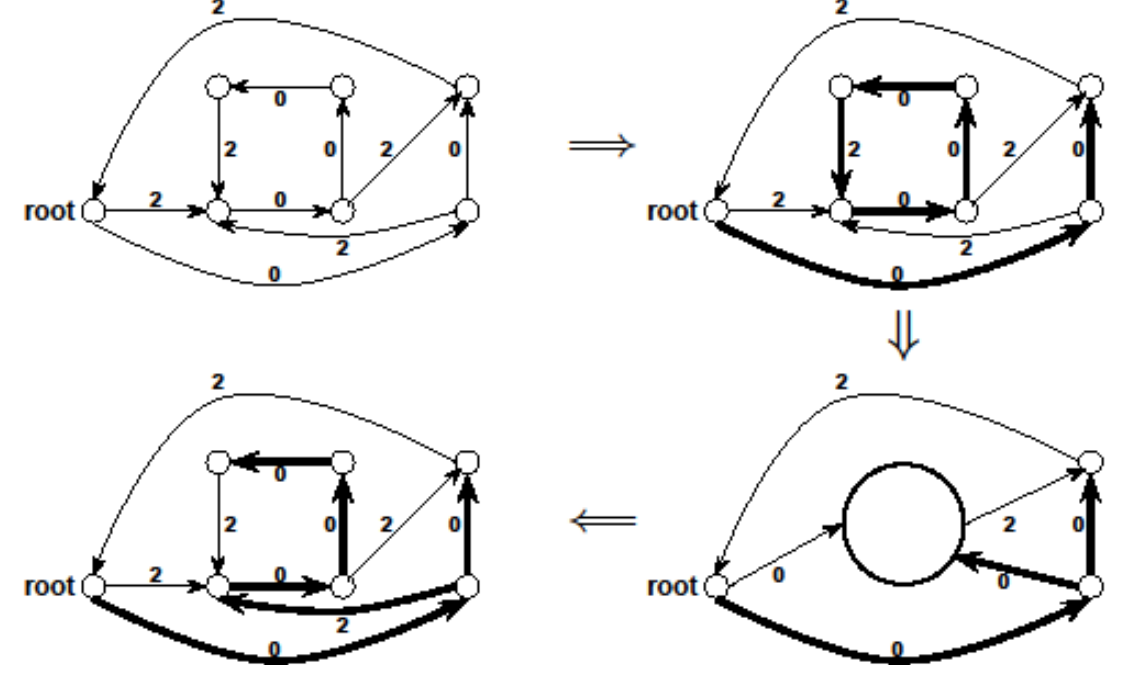
Figure 3. An illustration of the algorithm to compute a minimum weight spanning out-arborescence. The thick black edges at the final fourth step are the edges in the